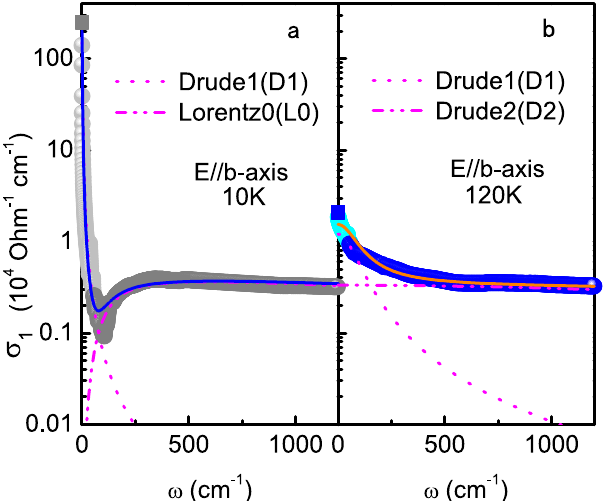
Figure 5. A tentative multi-component fit to the b -axis optical spectra at ( a ) 10 K and ( b ) 120 K. The spectra show clearly two-component behavior. The overall fit (solid lines) is in rough agreement with the dc conductivity and the extrapolated results (points) below 55 cm − 1 at both temperatures.